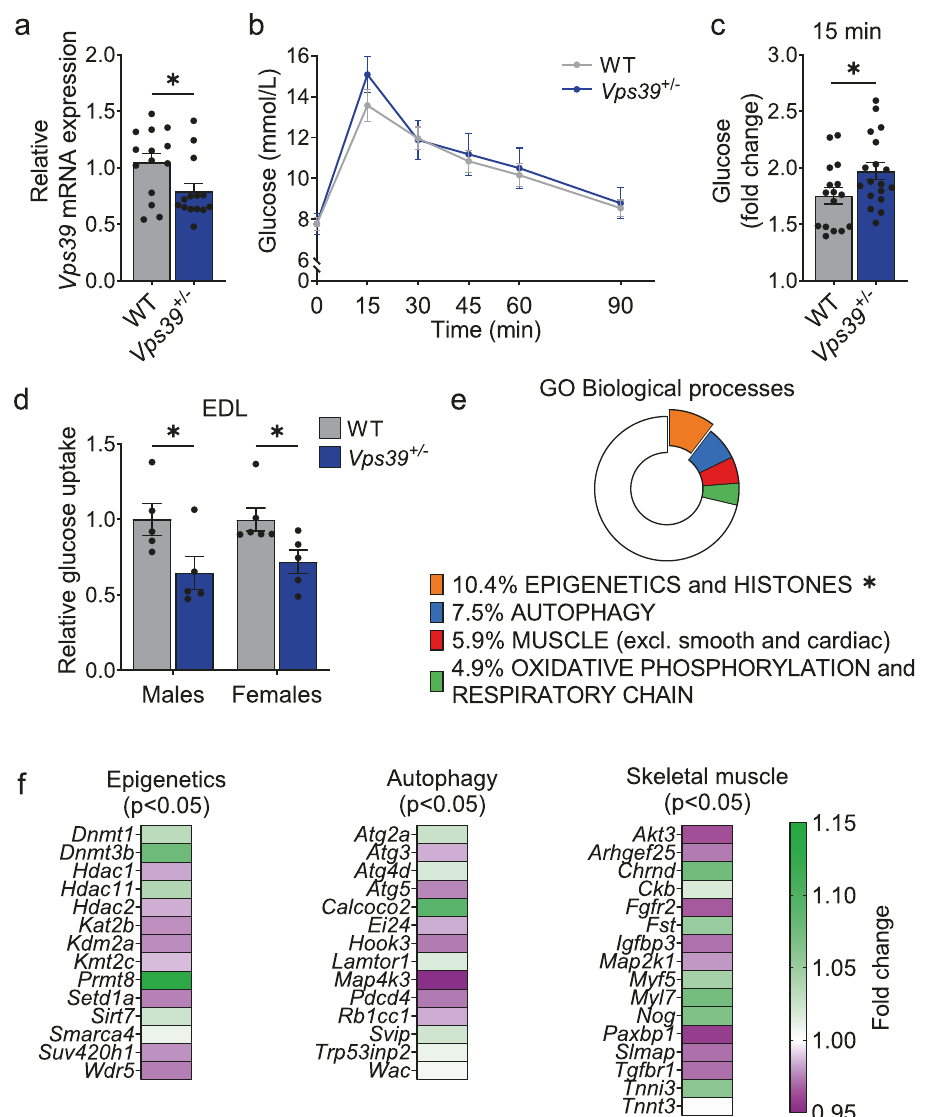
Fig. 5 Vps39-de fi ciency alters glucose metabolism and gene expression related to epigenetics, autophagy, and muscle function in mouse skeletal muscle. a mRNA expression (qPCR) of Vps39 in skeletal muscle (tibialis anterior) from heterozygous ( Vps39 + / − , n = 14, including six males and eight females, blue bars) and wild type (WT, n = 14, including seven males and seven females, gray bars) mice. * p < 0.05 for Vps39 + / − vs. WT. p = 0.0247. b – c Oral glucose tolerance test (OGTT) in Vps39 + / − mice ( n = 18, including ten males and eight females, blue points/bars) and WT mice ( n = 16, including ten males and six females, gray points/bars). b Blood glucose levels (mmol/L) at 0 – 90 min during the OGTT. c Fold change in blood glucose levels during the fi rst 15 min of the OGTT (glucose levels at 15 min relative 0 min). * p < 0.05 for Vps39 + / − vs. WT. p = 0.0451. d Relative glucose uptake in the extensor digitorum longus (EDL) muscle from Vps39 + / − and WT mice during 45 min after an oral glucose load. Glucose uptake in muscle was measured using 2-[1,2- 3 H(N)]-Deoxy-D-glucose tracer and normalized to tissue weight. Males: n = 5 WT and n = 5 Vps39 + / − , females: n = 6 WT and n = 5 Vps39 + / − . WT mice are set to 1. * p < 0.05 for Vps39 + / − vs. WT. p = 0.0474 (males), p = 0.0307 (females). e – f mRNA expression analysis (microarray) in skeletal muscle (tibialis anterior) from Vps39 + / − vs. WT mice ( n = 12 per genotype, including six males and six females per genotype). e Frequency of selected GO terms ( “ Epigenetics and Histones ” [orange], “ Autophagy ” [blue], “ Muscle ” [red] and “ Oxidative phosphorylation and Respiratory chain ” [green]) among the differentially expressed genes ( p < 0.05 for Vps39 + / − vs. WT). Chi 2 -tests were used to analyze overrepresentation of differentially expressed genes belonging to a GO term compared with all analyzed genes. * p -chi 2 < 0.05 compared to all analyzed genes. f Heatmap showing the fold change in expression for some selected differentially expressed genes ( p < 0.05 for Vps39 + / − vs. WT) related to the GO terms in ( e ) ( “ Epigenetics ” , “ Autophagy ” or “ Muscle ” ), based on GO annotation or previously published research. Genes with upregulated expression in Vps39 + / − mice displayed in green and downregulated expression displayed in purple. For exact p -values see Supplementary Data 5, Sheet A. GO gene ontology. Bars (in ( a , c – d )) or points (in ( b )) represent mean values and error bars display SEM ( a – d ). Statistical signi fi cance determined by unpaired two-tailed t -test ( a , c – d ). Differential gene expression between Vps39 + / − and WT mice was analyzed by unpaired two-tailed t -tests ( e – f ).